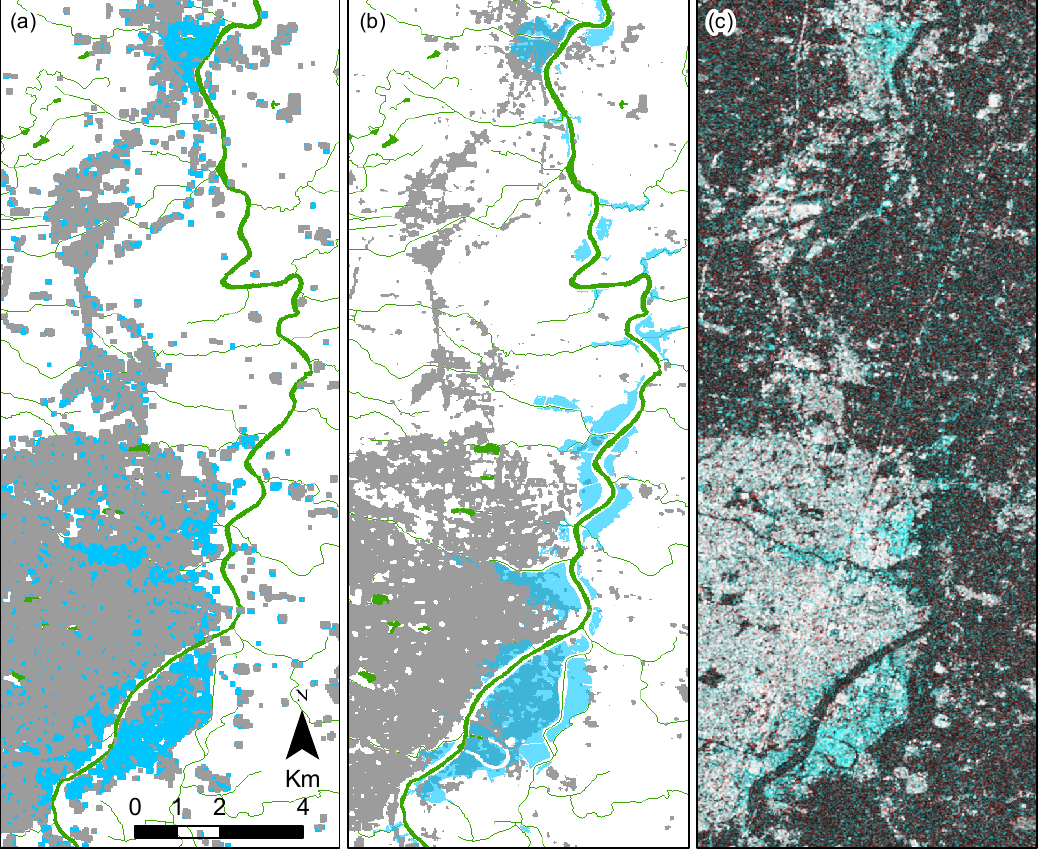
Figure 6. Closer look of the affected area in the city of Koriyama, Fukushima Prefecture. ( a ) The predicted flood map. ( b ) The reference flood map provided by GSI. ( c ) The RGB coherence color composite. Their locations are indicated in Figure